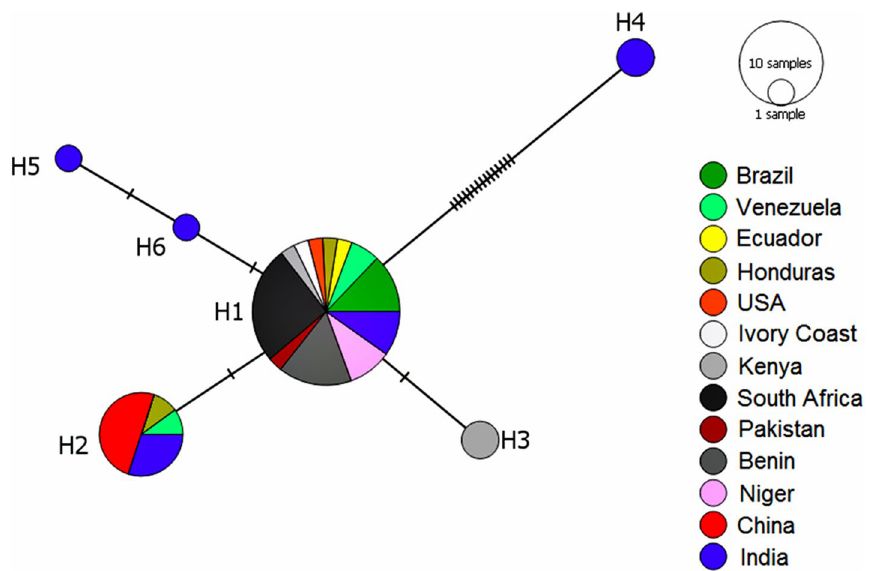
Figure 4. Haplotype network based on COI gene fragment sequences for Telenomus remus from 13